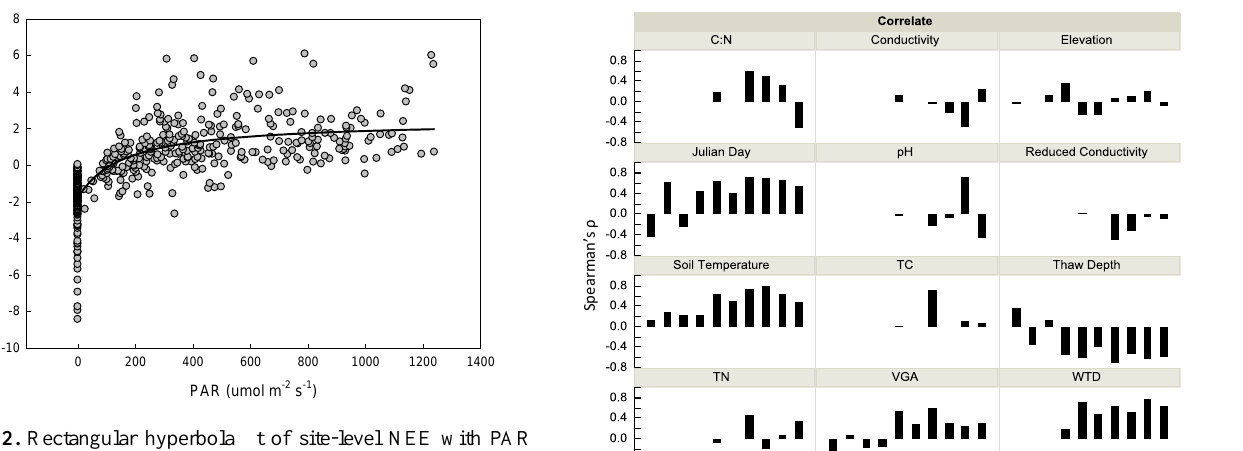
Figure 2. Rectangular hyperbola fit of site-level NEE with PAR ( n = 525).